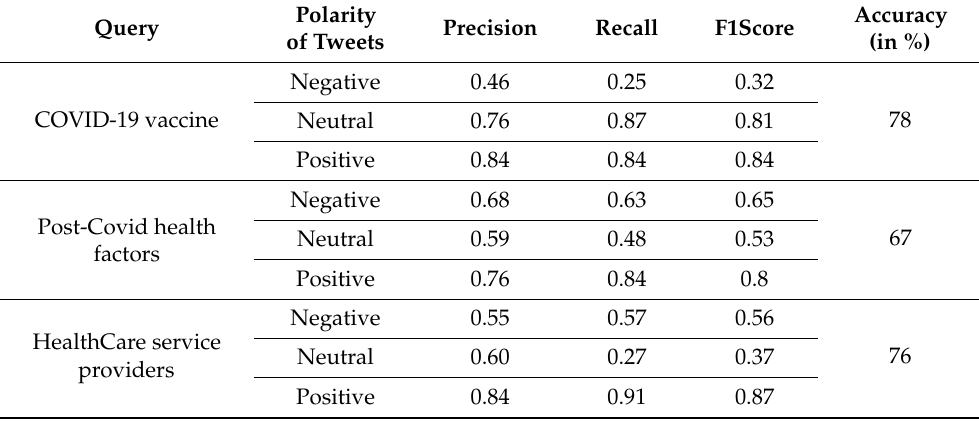
Table 8. LSTM model evaluation results for all three considered queries.